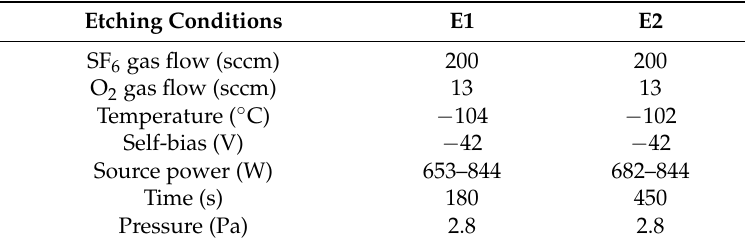
Table 1. Etching parameters for 3D silicon material with trenches structure with an aspect ratio (=trenches depth/width) of 3 (E1) and with trenches structure with an aspect ratio of 7 (E2). Etching Conditions